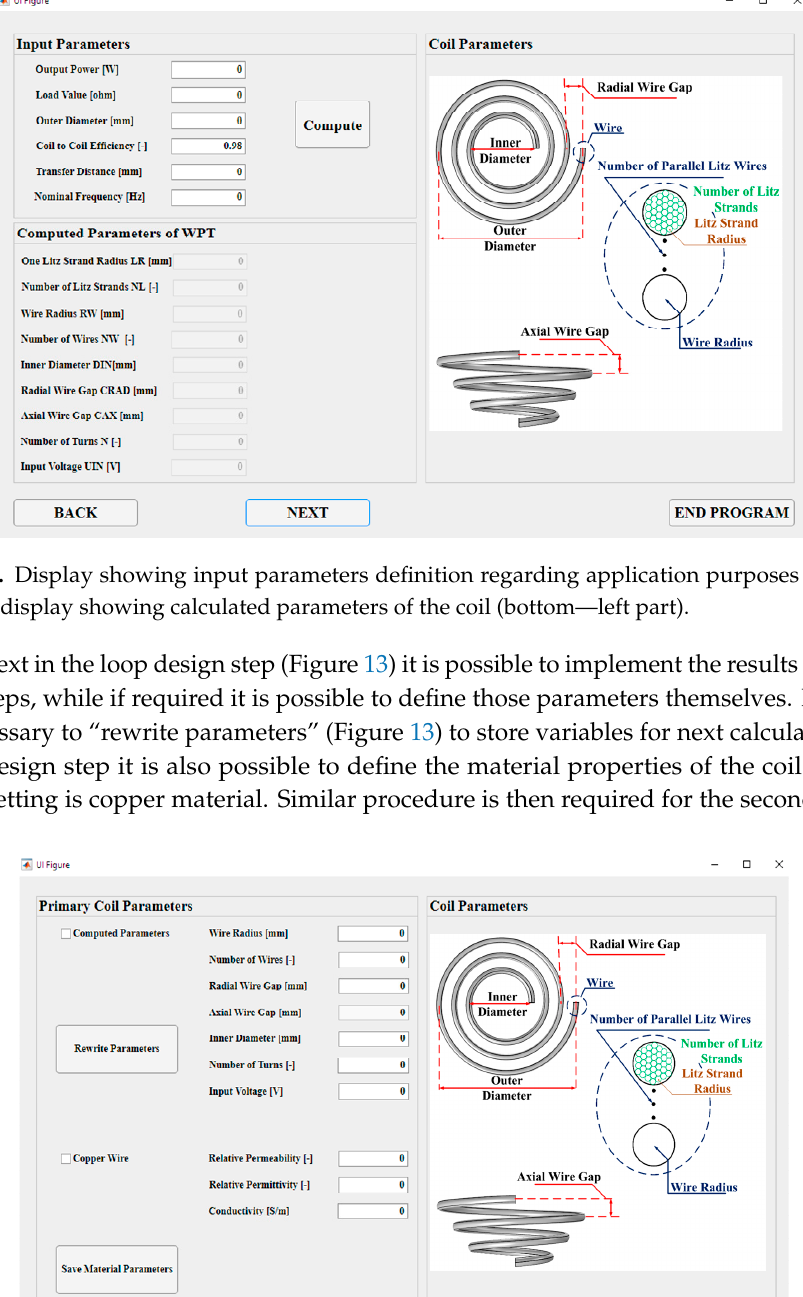
Figure 12. Display showing input parameters definition regarding application purposes (top—left part) and display showing calculated parameters of the coil (bottom—left part).